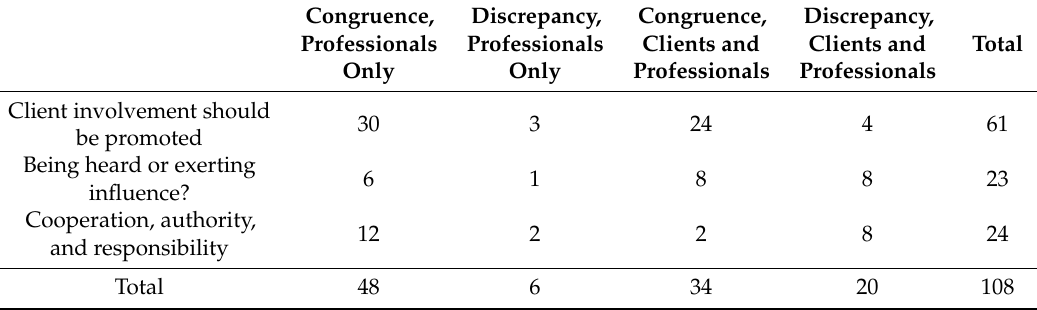
Table 1. The number of interaction segments with mutual congruence / discrepancy of viewpoints in the groups of professionals only and in the groups of both clients and professionals. Discrepancy, Congruence, Discrepancy, Congruence, Clients and Total Clients and Professionals Professionals Professionals Professionals Only Only Client involvement should 30 3 24 be promoted